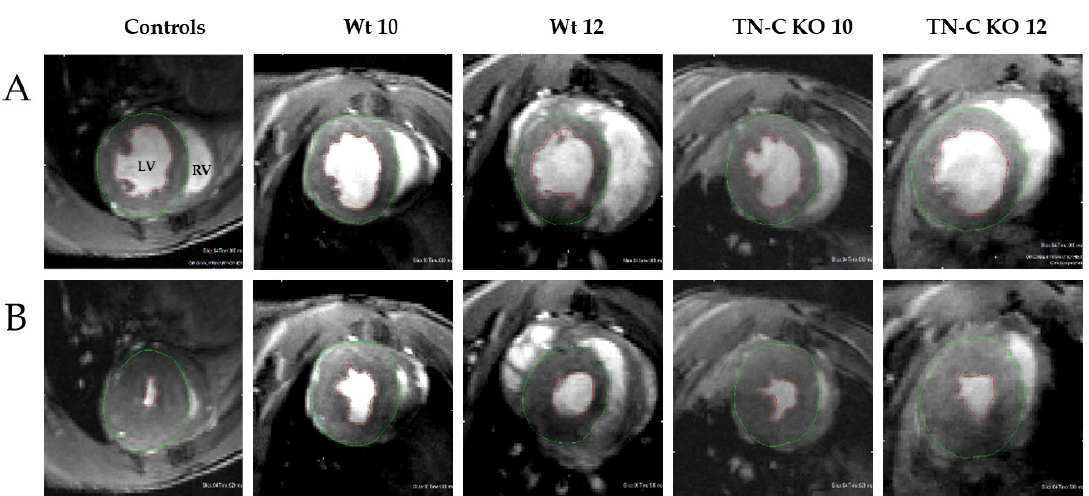
Figure 1. Comparison of short-axis MRI of an arbitrary mouse from each group (controls, Wt 10, Wt 12, TN-C KO 10, TN-C KO 12) in the end-diastole ( A ) and end-systole ( B ) phases of the cardiac cycle. Left ventricular (LV) and right ventricular (RV) regions are indicated in the top-left image as an example; the LV endocardium is outlined in red and the LV epicardium is outlined in green. Wt: Wild type and TN-C KO: Tenascin-C knockout.